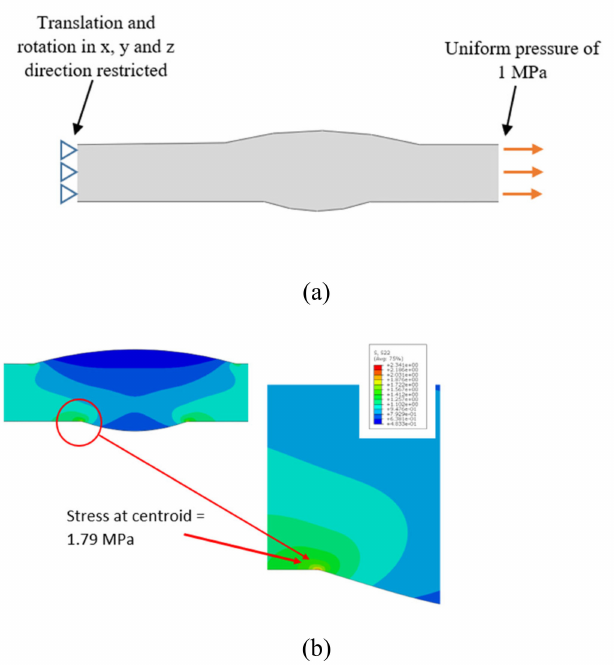
Figure 5. ( a ) Boundary conditions applied for the estimation of the k t ; ( b ) estimation of the geometrical k t of the samples using